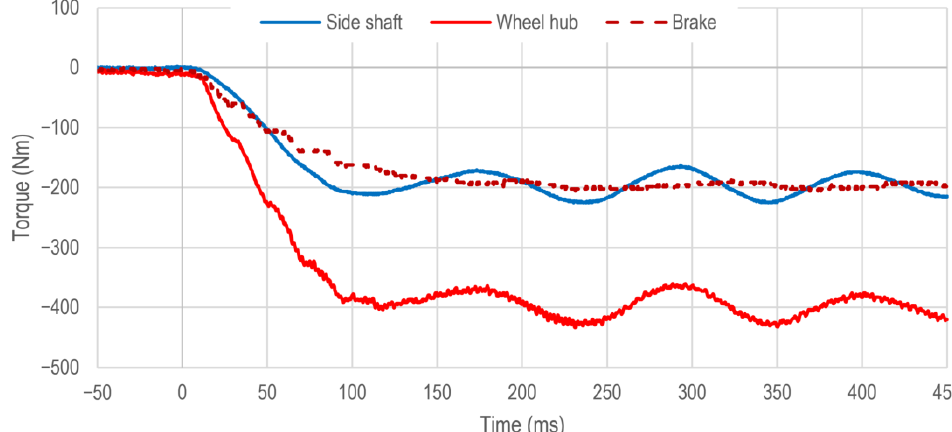
Figure 14. Braking operation with fixed 50/50 split between the drive machine and the conventional vehicle braking system from 25 km/h with activated prefilter and deactivated anti-jerk control. The course of the torque of the vehicle wheel hub 𝑀 WH is almost comparable with the course during the regenerative braking operation without activated anti-jerk control.